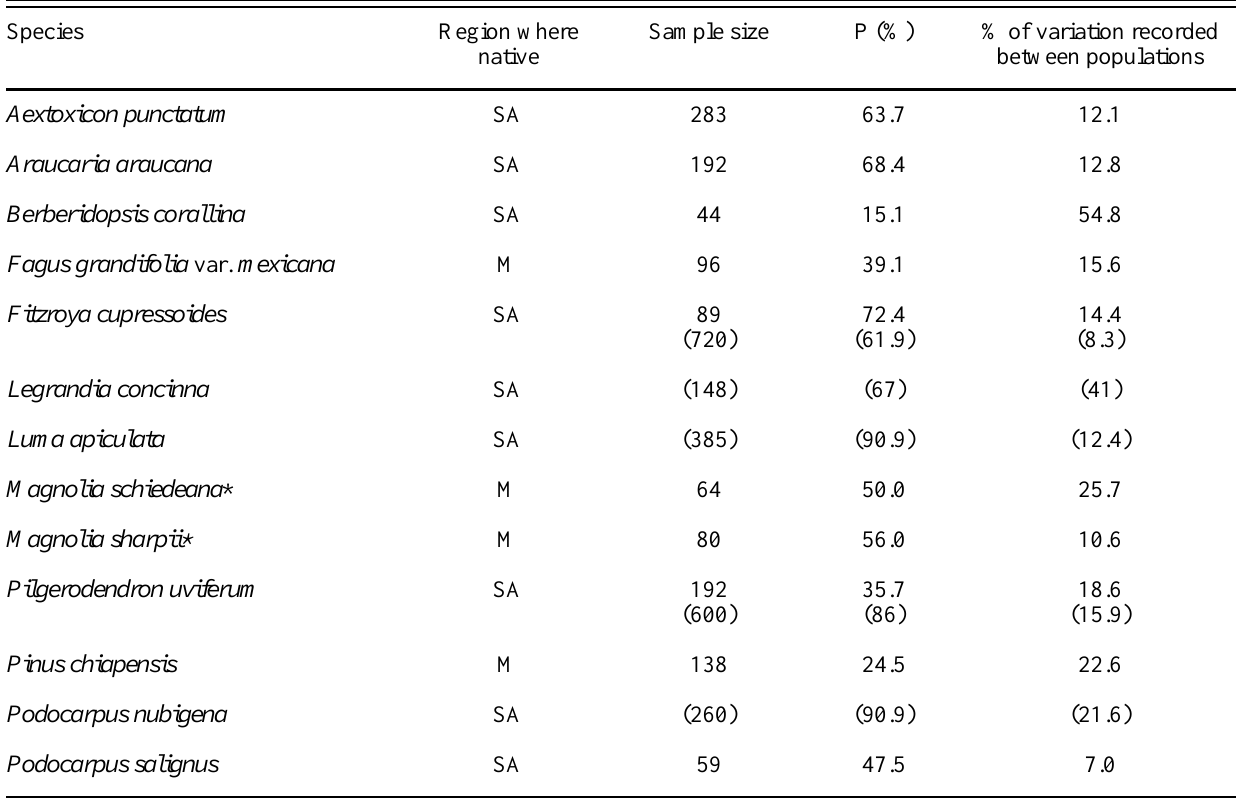
Table 3. Comparison of results obtained using DNA markers to assess patterns of genetic variation in woody species native to Mexico (M) and southern South America (SA). P% indicates percentage of polymorphic loci, a measure of the extent of genetic variation within species. (All results obtained with RAPD markers, apart from *, obtained with inter-SSR markers; values in parentheses obtained with isozyme markers). All species are trees apart from Berberidopsis , which is a woody vine. (Adapted from Premoli et al.